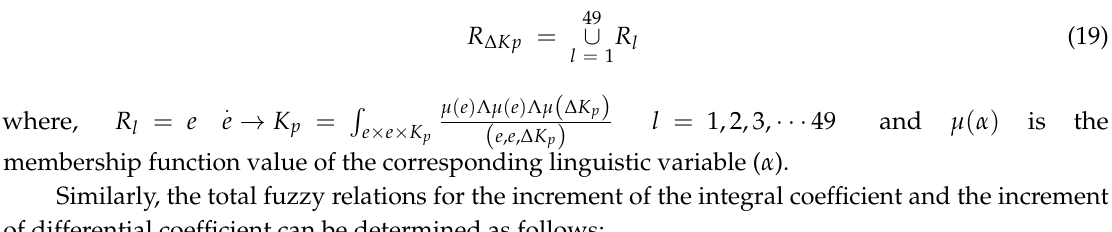
Table 1. Fuzzy inference rules of Δ K p , Δ K i and Δ K d .